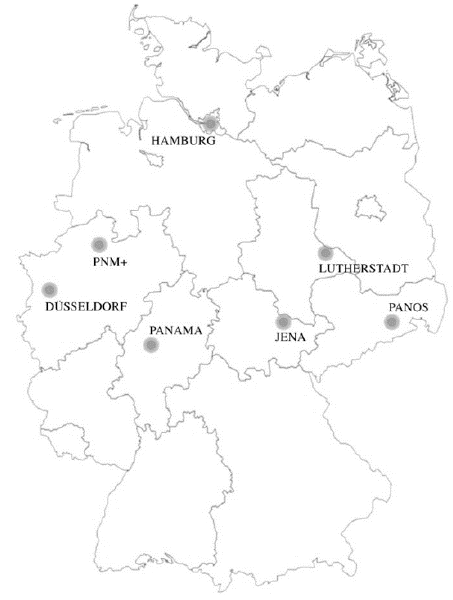
Figure 2. Parkinson Networks in Germany .